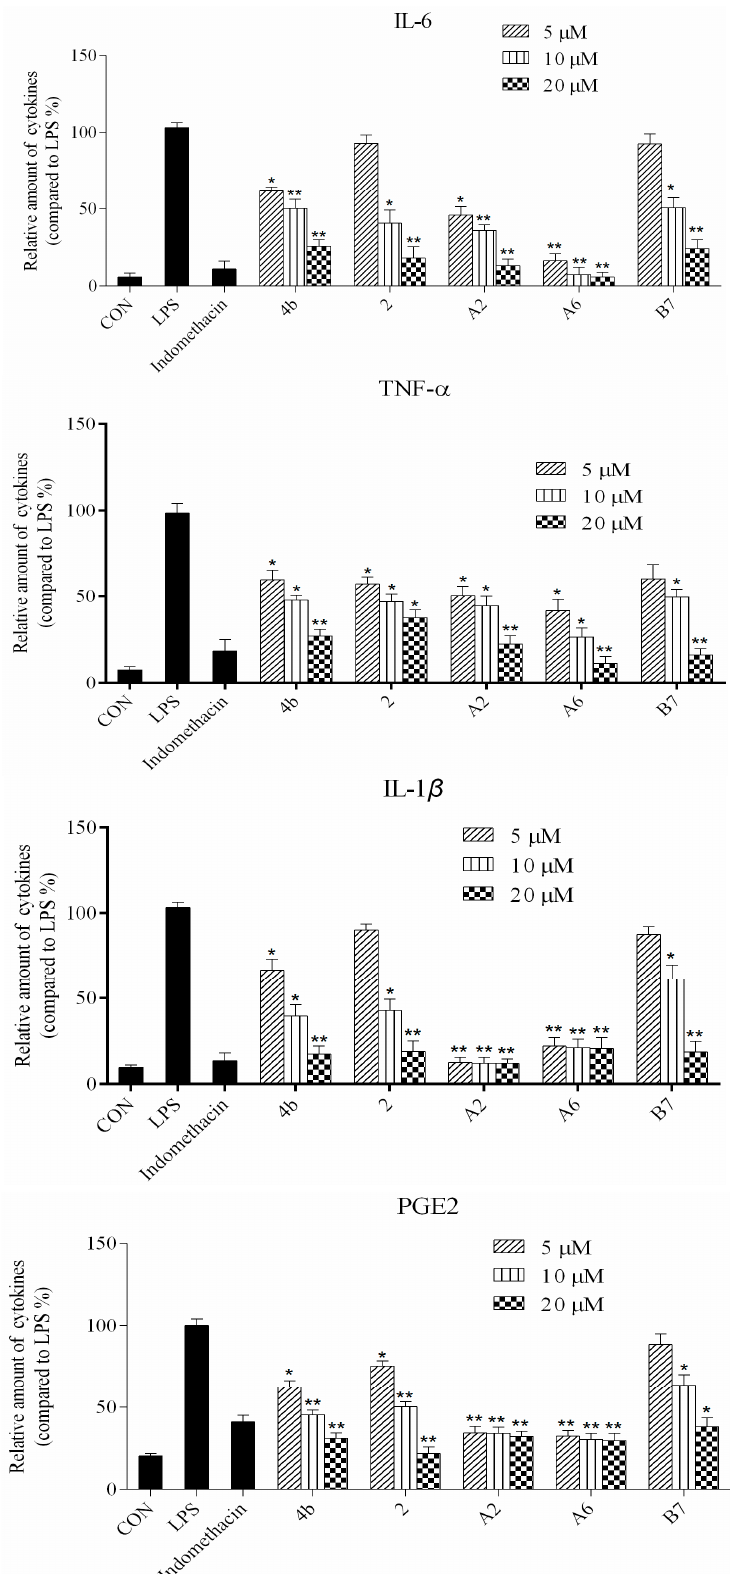
Figure 4. Compounds 4b , 2, A2, A6 , and B7 reduced the production of IL-6, TNF- α , IL-1 β , and PGE2 at concentrations of 5 μ M, 10 μ M, and 20 μ M (*: p < 0.05; **: p <